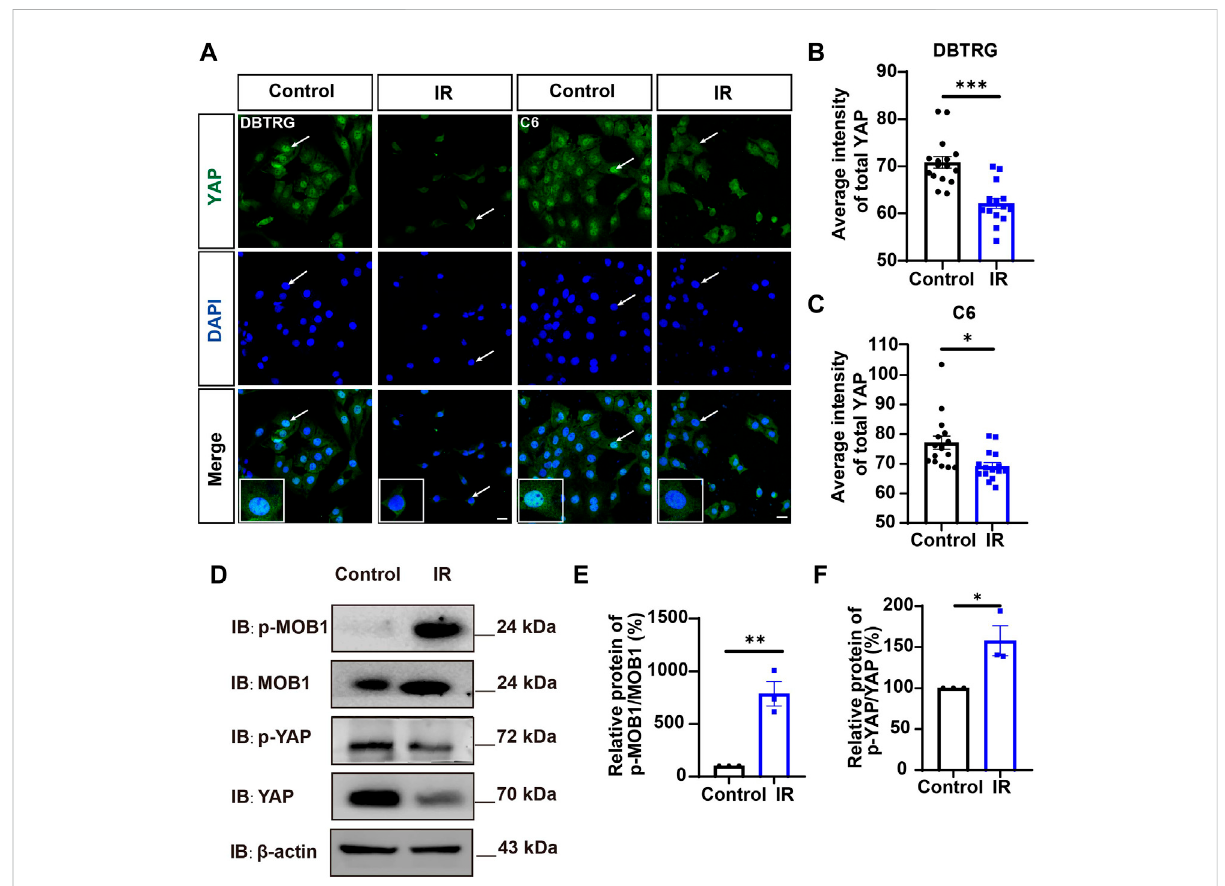
FIGURE 5 Irigenin downregulated YAP signaling in GBM cells. (A) Immunostaining of YAP in DBTRG and C6 cells treated with 40 μ M IR. (B – C) Quanti fi cationoftheintensity ofYAPinDBTRGcells (B) andC6cells (C) asshown in (A) ( n = 16,per group). (D) Western blotdetectedtheexpression of p-MOB1/MOB1 and p-YAP/YAP in DBTRG cells treated with 50 μ M IR. (E – F) Quanti fi cation of the relative level of p-MOB1/MOB1 (E) and p-YAP/ YAP (F) asshownin (D) ( n =3pergroup,normalizedtocontrol).Scalebars,20 μ m.Datawereshownasmean±SEM. *p < 0.05, **p < 0.01, ***p < 0.001, compared with control